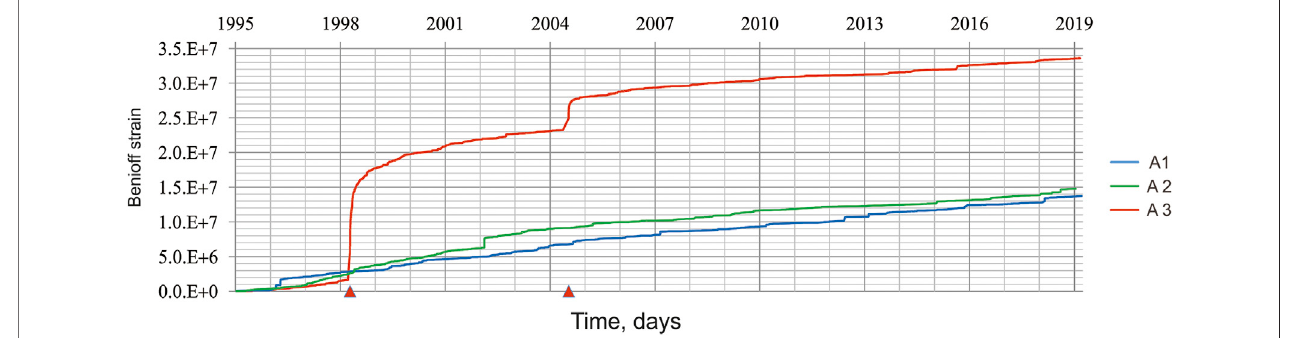
FIGURE 4 | The cumulative Benioff strain release Ʃ vs. earthquake origin time for three FVG sub-regions (1995 – 2019). The color code is the same as in Figure 3 : area A1 – blue line, A2 – green line, A3 – red line. The origin time of the two principal earthquakes ( Table 2 ) are marked with red triangles on the origin time scale.